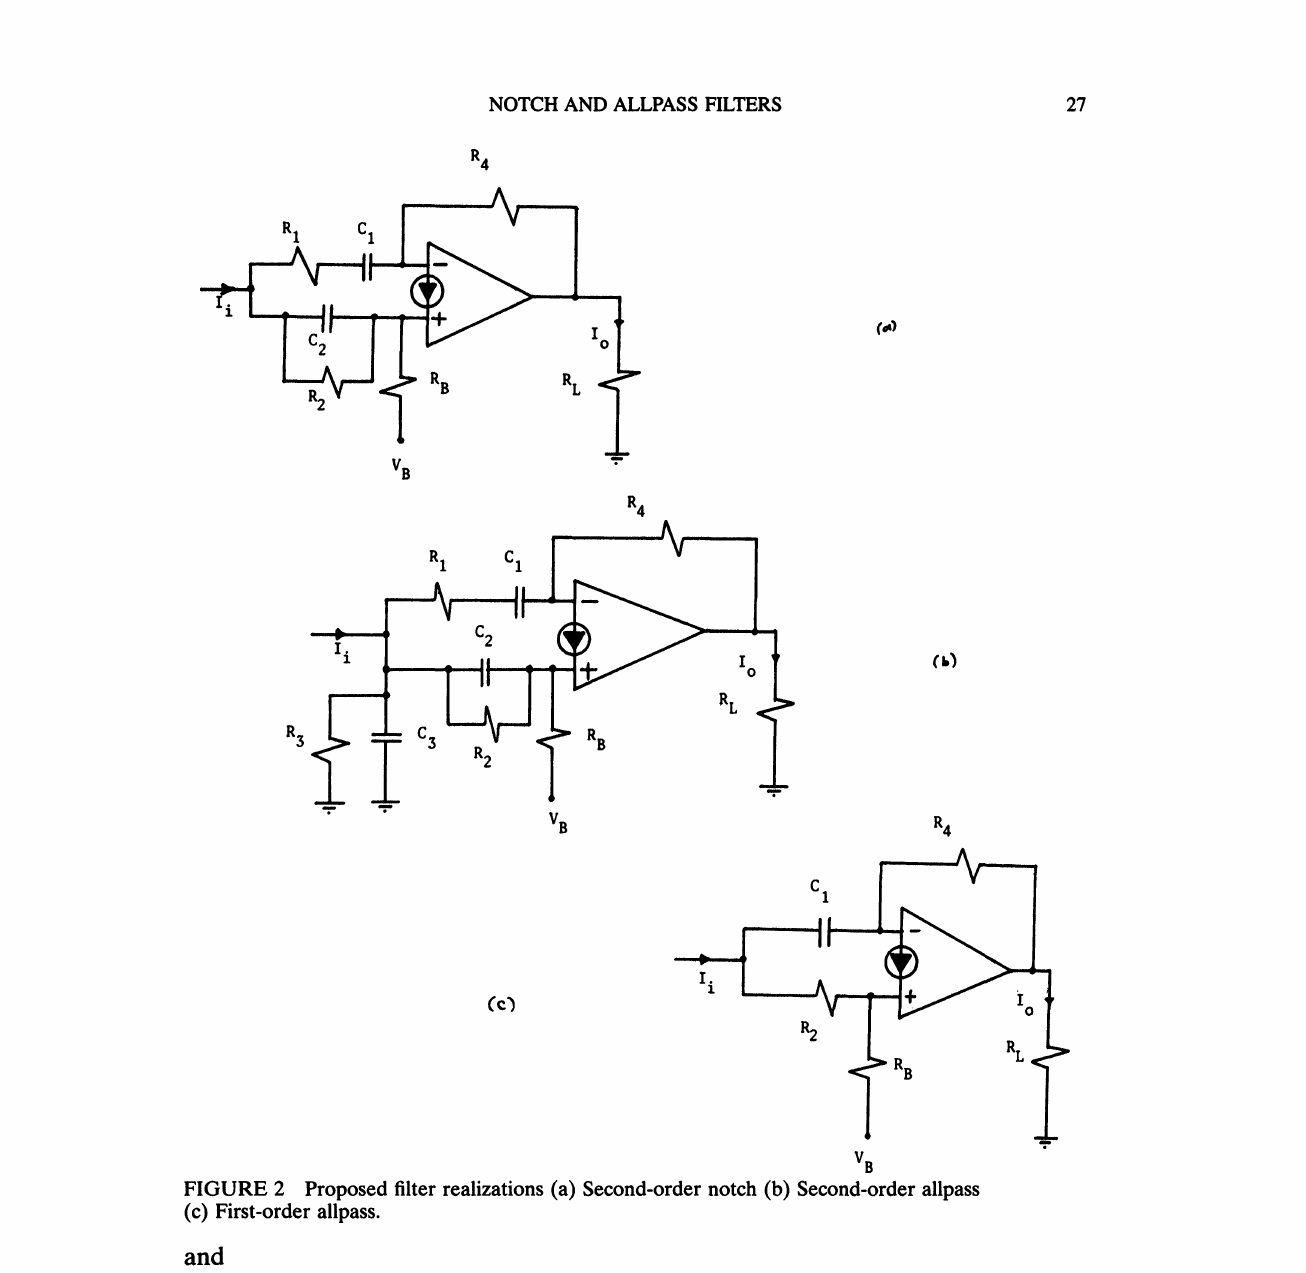
FIGURE 2 Proposed filter realizations (a) Second-order notch (b) Second-order allpass (c) First-order allpass.